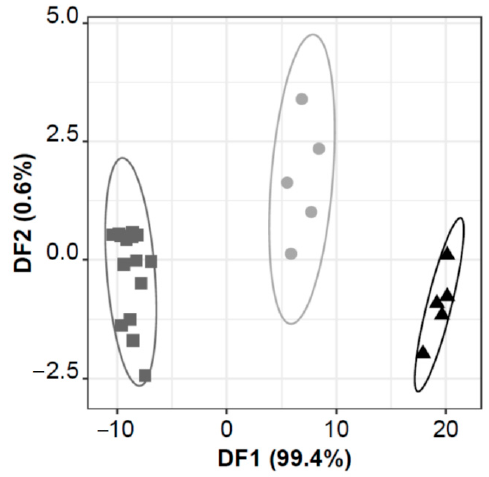
Figure 3. E-tongue-LDA discrimination of canned tuna according to the covering oil used: ● sun ‐ flower oil; ■ EVOOs with different fruity intensities (ripely fruity, greenly light fruity, and greenly intense fruity); and, ▲ refined olive oil. 2D ‐ plot of the first two discriminant functions (DFs) based on the potentiometric signals recorded by 13 lipid sensor membranes (S1:5; S1:6; S1:8; S1:14; S1:16; S1:18; S2:1; S2:2; S2:4; S2:11; S2:12; S2:16; and, S2:19), selected by the SA algorithm.